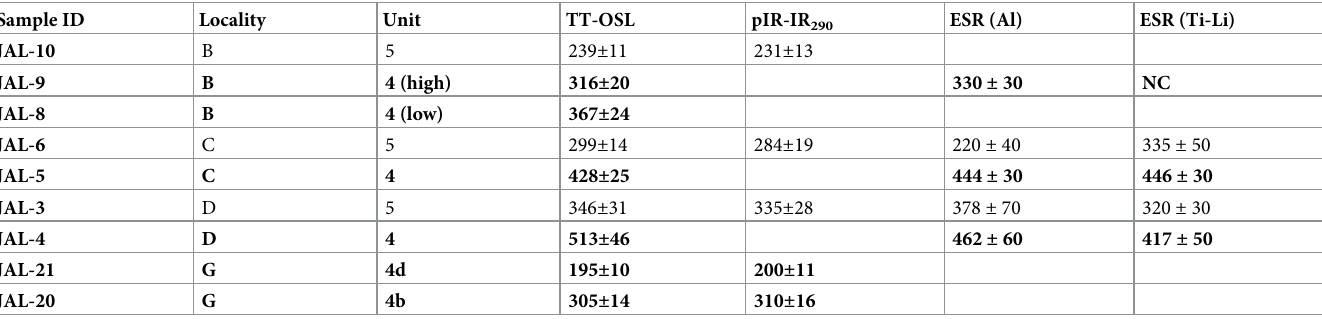
Table 11. Summary of absolute dating results for Unit 4 (in bold) and Unit 5 according to locality. Sample